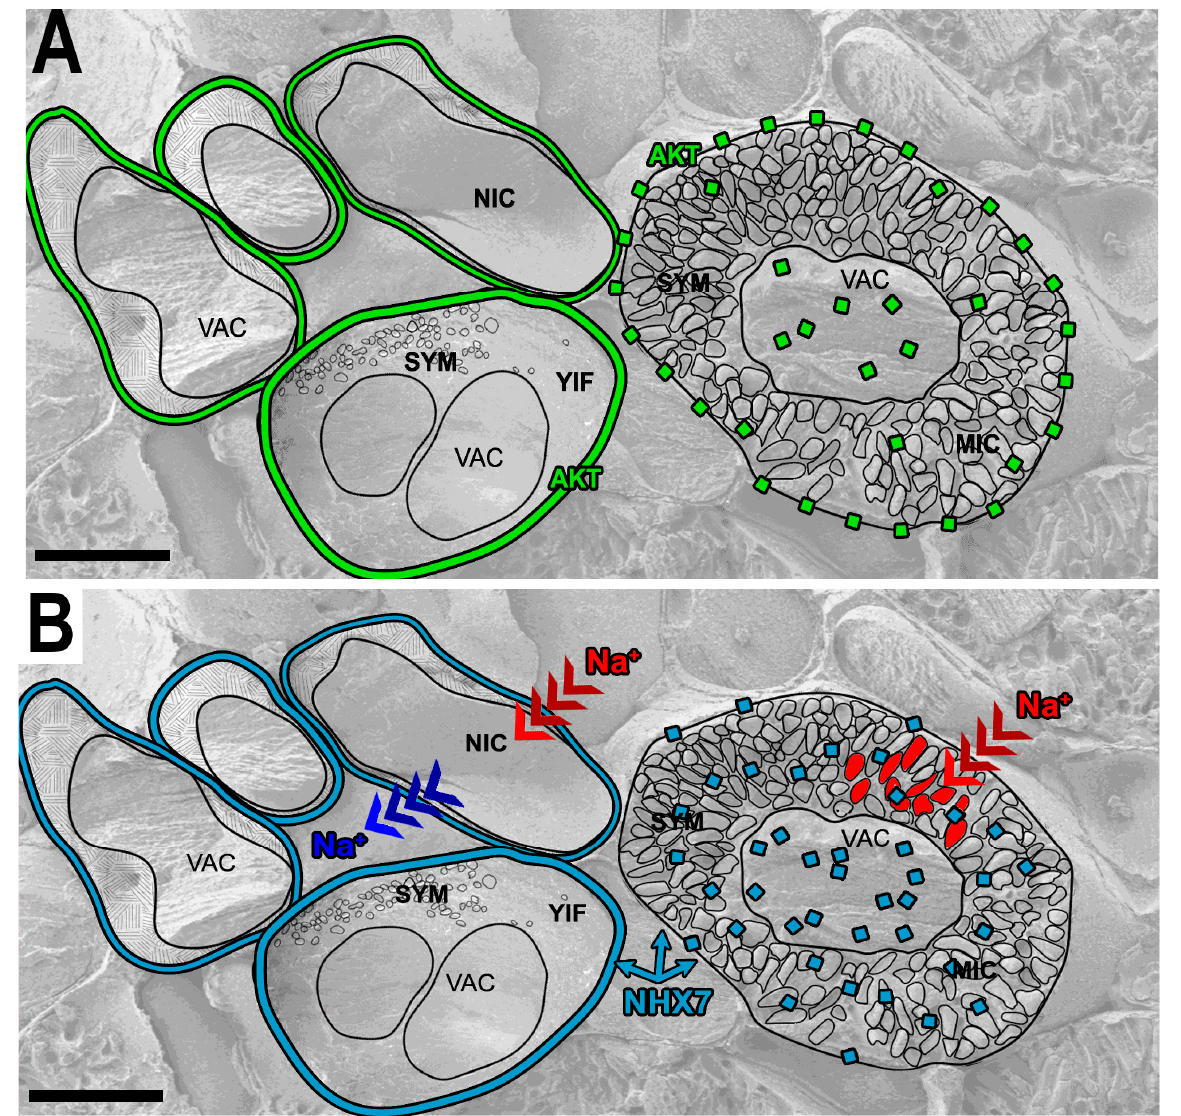
Figure 3. ( A , B ). Scheme of the distribution of the potassium channel AKT1 protein ( A ) and ion Na + /K + exchanger NHX7 protein ( B ) in infected and non-infected cells of a root nodule. ( A , B ) Both transporters in young infected(YIC) and non-infected cells (NIC) are located on the plasma membrane; membranes are labeled in green for AKT1 and in blue for NHX7. In mature infected cells (MIC), AKT1 and NHX7 proteins are shed from the plasma membrane (green dotted signal and blue dotted signal, respectively) and transferred to the host cell vacuole (Vac). Due to the dislocation of the NHX7 Na + /K + ion exchanger from the plasma membrane of the infected cell under the application of salt, Na + ions (red signal, red arrows) are transferred and accumulated in the infected cell and in symbiosomes (marked in red). In non-infected cells, Na + ions are transferred in and out of the plant cell (red and blue arrows) as the distribution of NHX7 on plasma membrane of non-infected cell is maintained correctly. Abbreviations: NIC—non-infected cell, YIC—young infected cell, MIC—mature infected cell, VAC—vacuole, T—tonoplast, PM—plasma membrane, IT—infection thread, SYM—symbiosomes. Bar: 12.5 µ